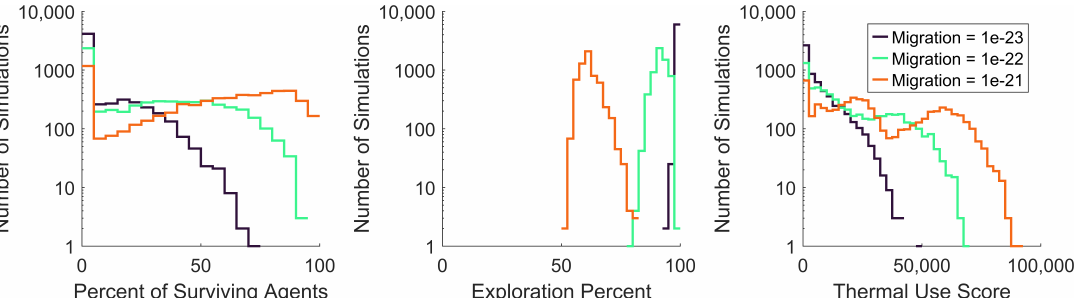
Figure 14. Distribution of swarm survival, exploration, and thermal use for all values of migration, including 1 × 10 − 23 , 1 × 10 − 22 , and 1 × 10 − 21 . All histogram values showing a number of simulations are plotted on a logarithmic